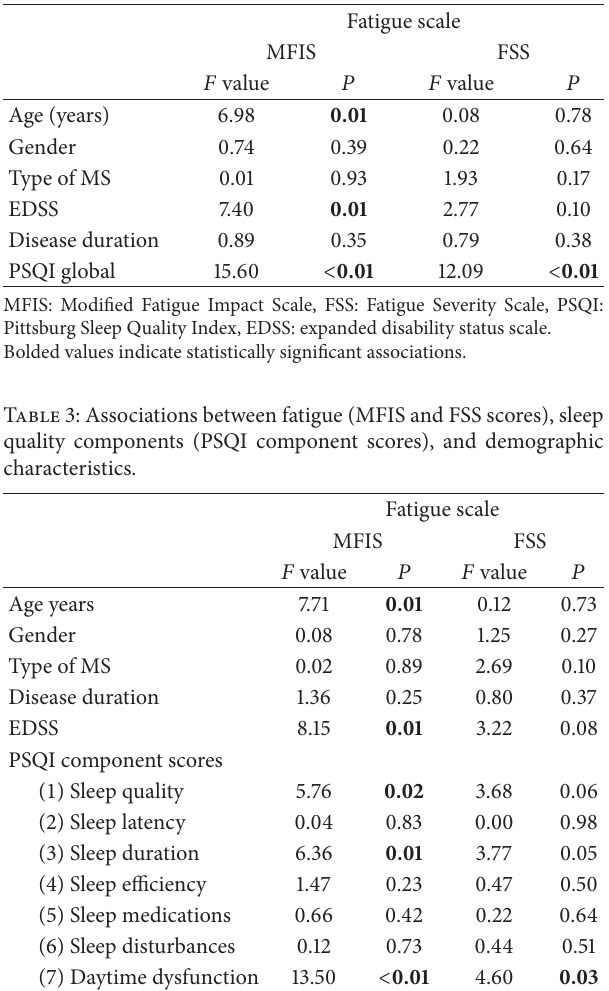
Table 2: Associations between fatigue (MFIS and FSS scores), sleep quality (PSQI global score), and demographic characteristics.